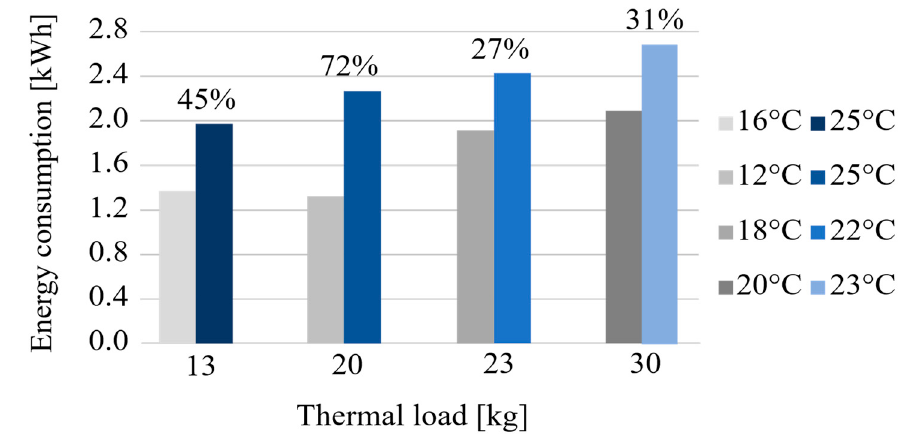
Figure 9. Energy consumption at different conditions of ambient temperature.